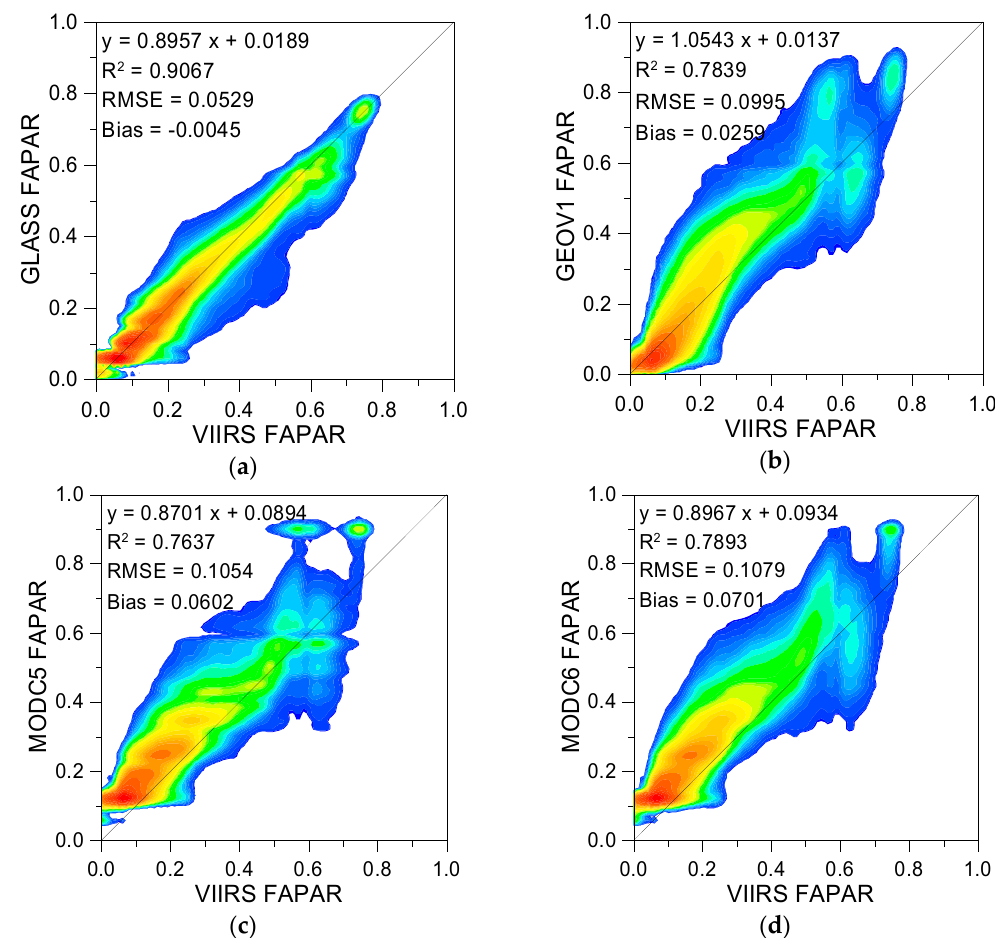
Figure 6. Density scatterplots between the VIIRS FAPAR values and the GLASS ( a ); GEOV1 ( b ); MODC5 ( c ); MODC6 ( d ) FAPAR values for tile h09v05 on day 185, 2013. Only collocated FAPAR values among these FAPAR products are included.